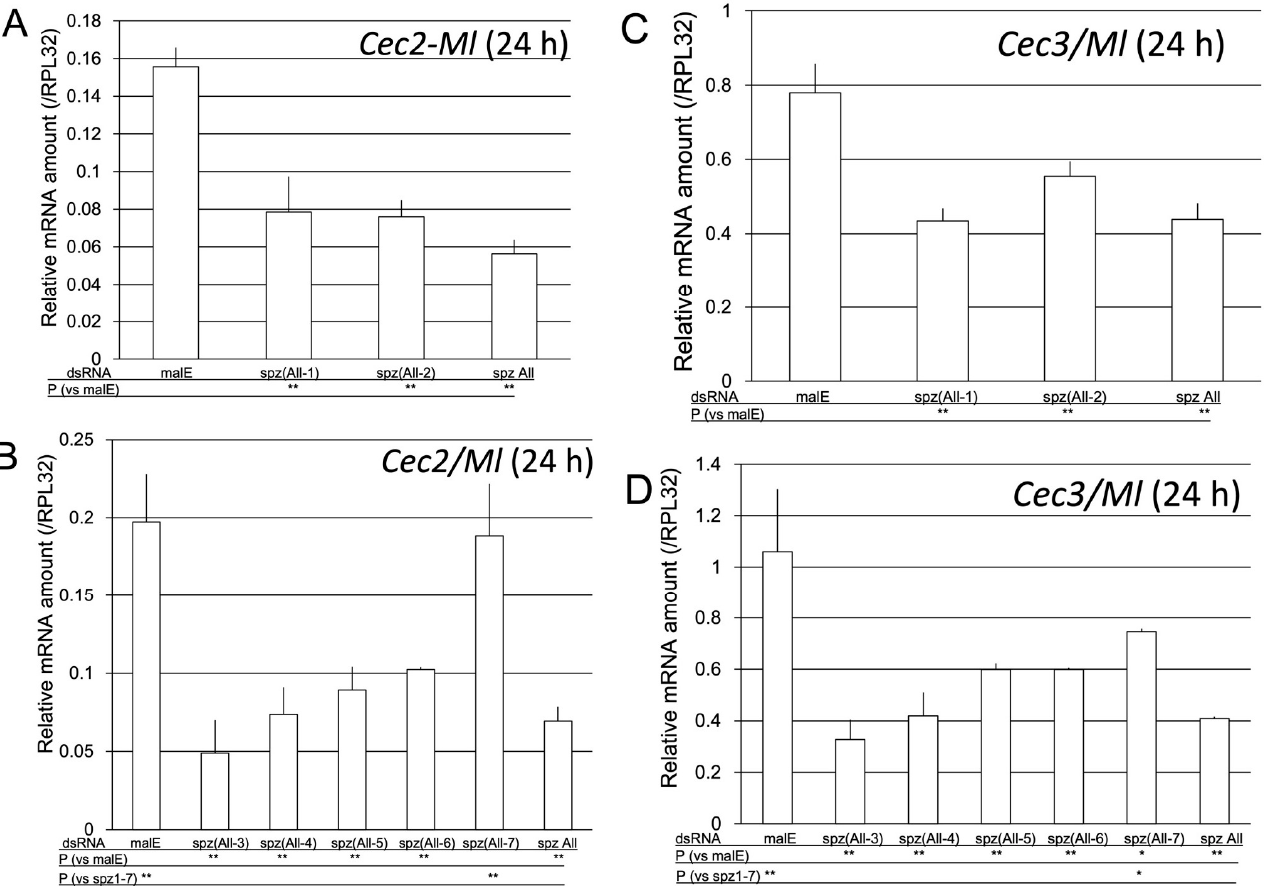
Figure 11. Effect of knockdown of six spz genes on Cec2 ( A ) and Cec3 ( B ) induction by M. luteus (Ml). The mRNA levels of Cec2 ( A , B ) and Cec3 ( C , D ) were measured in pupae pretreated with malE dsRNA (control), all seven spz dsRNAs (spz All, control), or six spz dsRNAs (e.g., spz(All-3) indicates knockdown of spz1, 2, 4, 5, 6 , and 7 ) at 24 h after Ml challenge. The mRNA levels of the genes are shown as relative values to RPL32 mRNA levels in the same samples. Experiments with three animals were independently repeated three times, and each column represents the mean ± S.D. Asterisks and double-asterisks indicate p < 0.05 and p < 0.01 (simultaneous confidence interval) compared to malE dsRNA-treated samples (P (vs. malE)) or spzAll samples (P (vs. spz1–7)), respectively, according to Tukey’s honestly significant difference test. The P (vs. spz1–7) row was omitted in ( A , C ) because the Cec2 or Cec3 mRNA level in spz(All-1) and spz(All-2) pupae was not significantly different from that in spz All pupae.